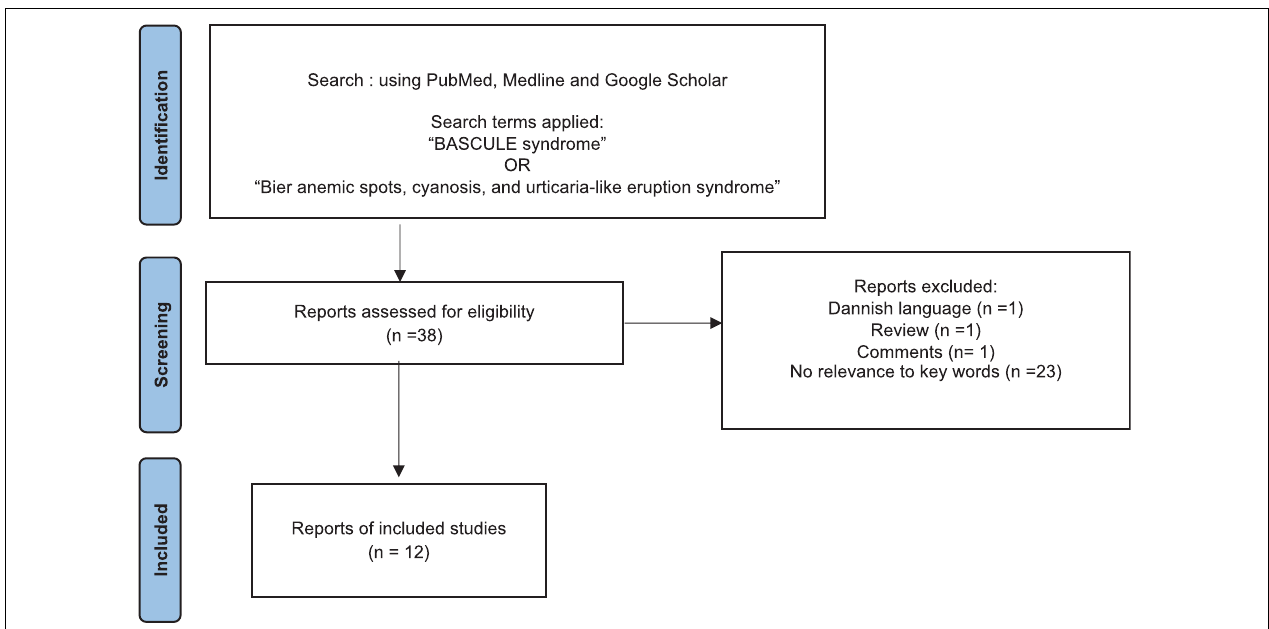
FIGURE 1 | Study selection flowchart. We conducted a literature review using the terms “BASCULE syndrome” OR “Bier Anemic spots, cyanosis, and urticaria-like eruption syndrome” in PubMed, Medline, and Google Scholar databases. The process of study selection is synthesized. The causes of exclusion at each step are reported (the number of studies excluded for each individual cause). Of the 38 publications retrieved by the literature search, 12 were